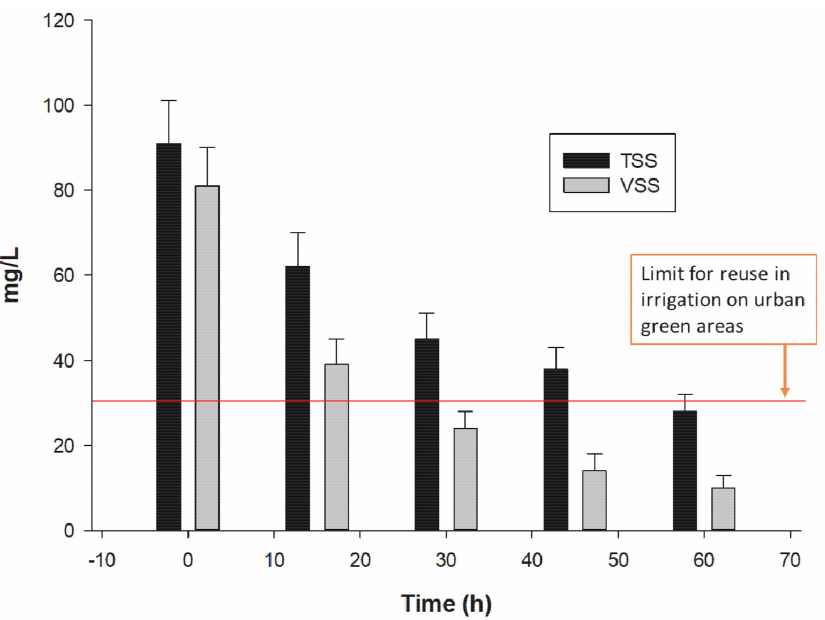
Figure 3. Solid suspended removal by treatment with ultrasound at a frequency: 20 kHz, amplitude: 35% and sonication time: 15, 30, 45, 60 min. TSS = Total suspended solids and VSS = Volatile suspended